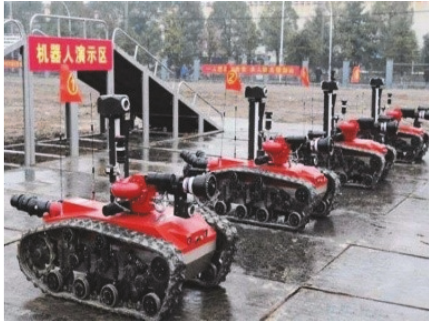
Figure 11: CITIC Kaicheng’s firefighting